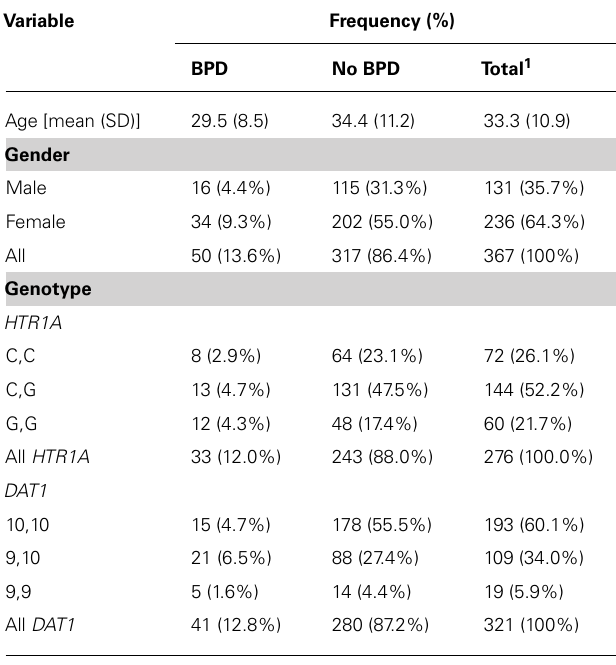
Table 1 |The frequency of age, gender and DAT1 and HTR1A genotypes, with the prevalence of